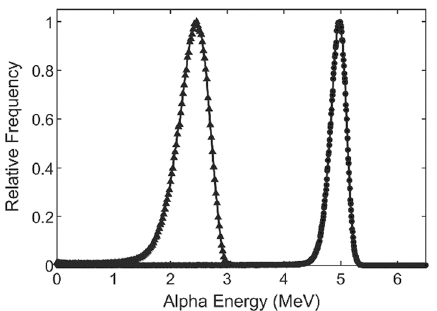
Fig. 3 Measured 241 Am source alpha energy spectra detected by PIPS detector (circles) and simulated energy spectra of alpha particles reaching the bottom of the cell well